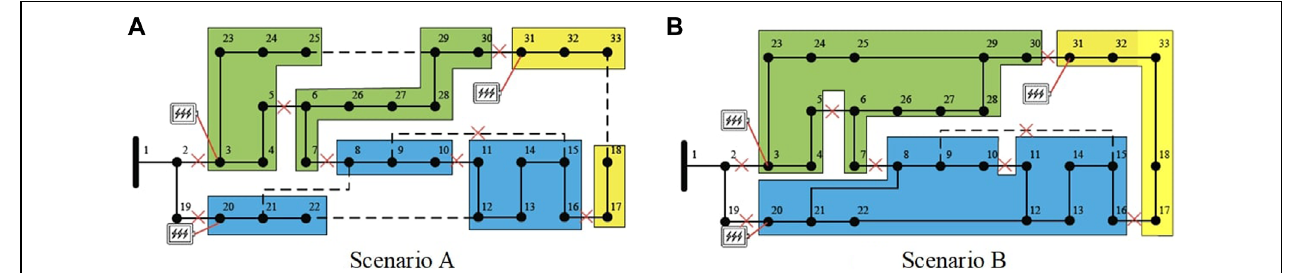
FIGURE 6 | Post-disaster outage scenarios (A) : Scenario A, (B) : Scenario B (Scenario A after